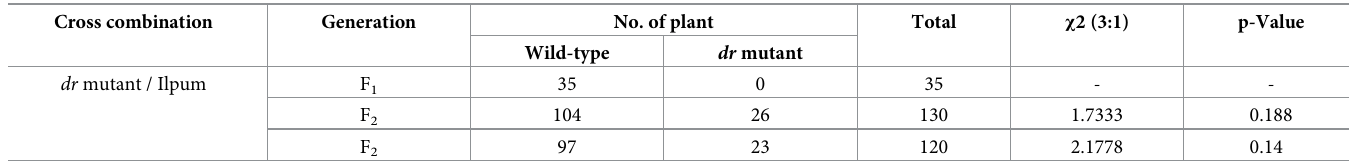
Table 2. Genetic segregation of the drooping leaf trait in F 1 and F 2 populations derived from a cross between the wild-type and dr mutant ( χ 2 0.05(1) = 3.841). Cross